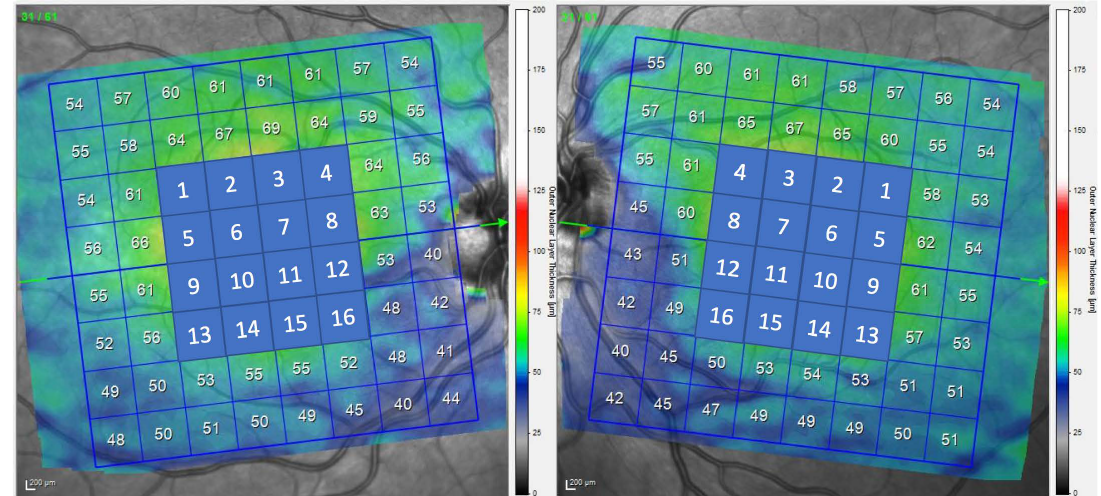
Figure 1. OCT scan of the macula with the posterior pole analysis (PPA) showing the 16 sectors numbered from 1 to 16. The nasal sector included the numbered 3, 4, 7, 8, 11, 12, 15, and 16 sectors; the temporal sector included 1, 2, 5, 6, 9, 10, 13, and 14; and superior from 1 to 8, whereas inferior from 9 to 16 sectors. Green arrows represent the horizontal line centred in